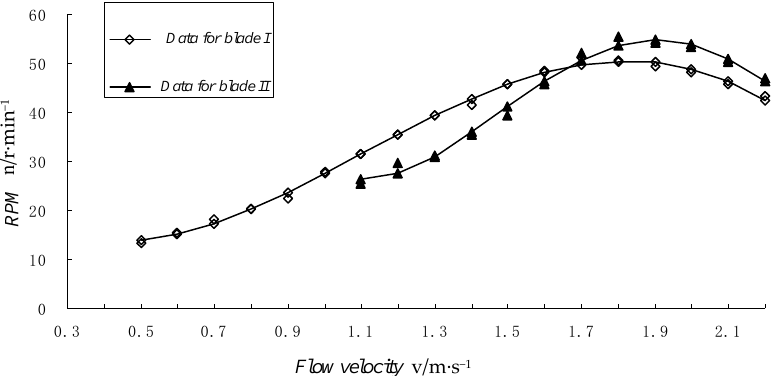
Figure 14. RPM of the blade at different velocities.